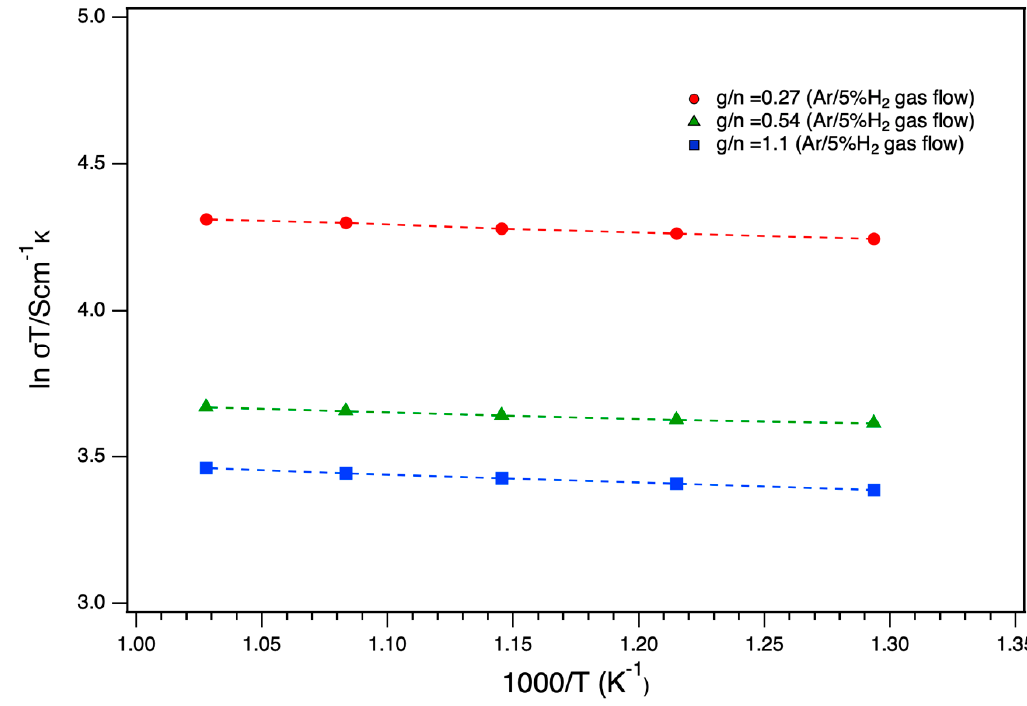
Figure 6. Arrhenius-type plot of the total conductivity at intermediate temperatures for the reduced Ni/ScSZ with different g/n ratios under Ar/5%H 2 gas flow environment from 500 °C to 700 °C. Among the g/n ratios, 0.27 showed the highest total conductivity. At 700 °C, the total conductivity of the 0.27 g/n sample was 4.5 × 10 − 3 S/cm and 1.2 × 10 − 2 S/cm under Ar and O 2 gas flow